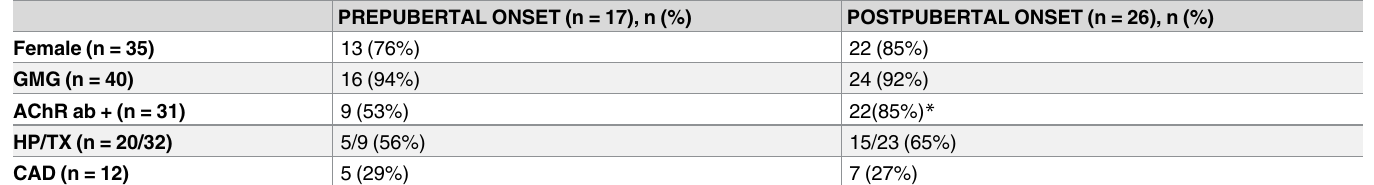
Table 1. Clinical characteristic of the Norwegian juvenile myasthenia gravis cohort stratified by age at onset. PREPUBERTAL ONSET (n = 17), n